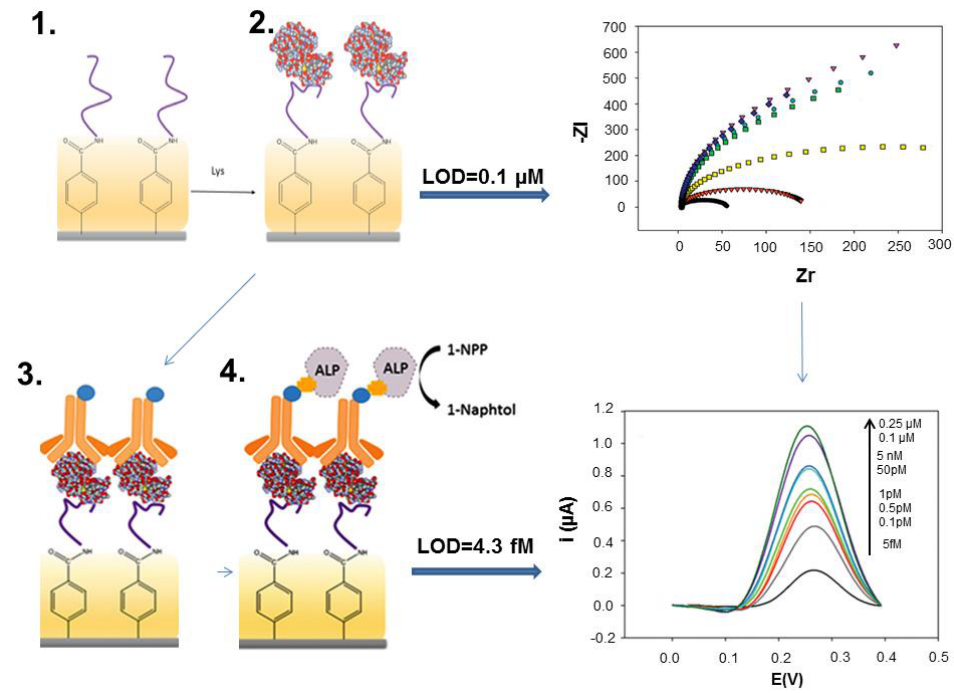
Figure 7. Illustration of two configurations used in screen-printed aptasensors for lysozyme analysis in wine. Steps 1 and 2 depict the construction of an impedimetric aptasensor where a biotinylated aptamer is covalently immobilized on a carboxyl-functionalized surface ( 1 ). Lysozyme binding ( 2 ) is detected directly by EIS. In a second assay, a biotinylated antibody is added after lysozyme binding ( 3 ), this detection antibody is labeled with streptavidin-alkaline phosphatase conjugate (ALP), the enzyme substrate, 1-naphtyl phosphate (1-NPP) is added ( 4 ) and the enzymatic product 1-naphtol is detected by DPV. Introduction of steps 3 and 4 and detection by DPV allowed improving the detection limit from 0.1 µM to 4.3 fM. Adapted from [39] and [34] with permission.